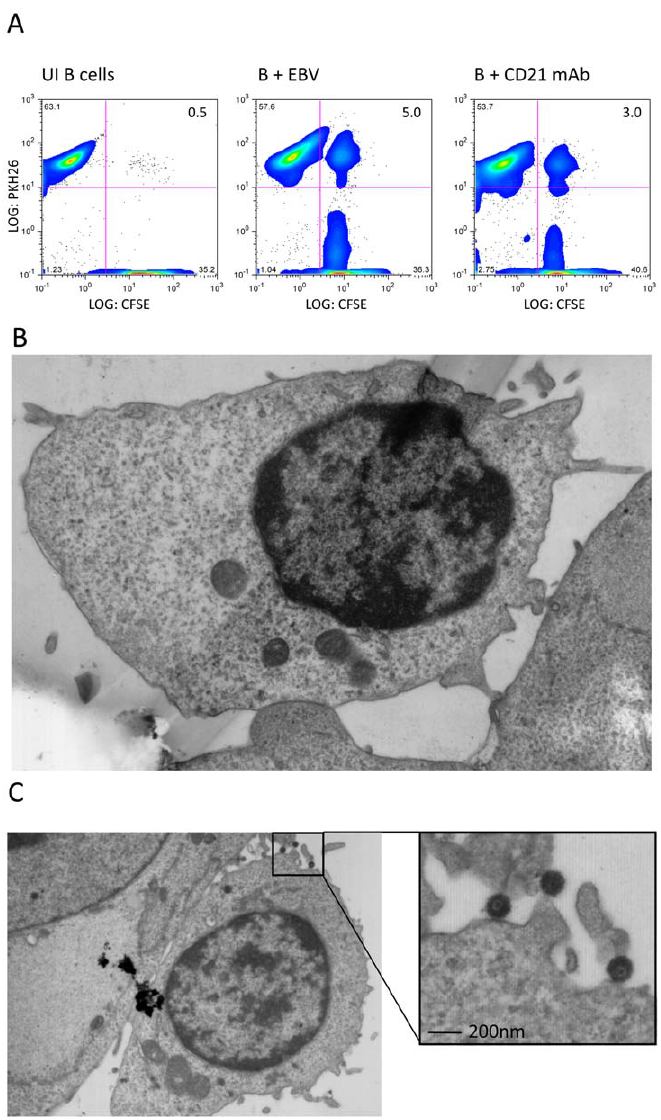
Figure 1. EBV induces firm adhesion between B cells and epithelial cells. (A) FACS profiles of conjugate formation between CFSE-labelled primary tonsillar epithelial cells (x-axis) and PKH26-labelled primary B cells (y-axis). The B cells were uninfected, EBV-infected (MOI 100, 24 h p.i.) or incubated with agonist mAb to CD21 (BL13). Conjugates appear in the upper right quadrant and the percentages of cells are shown. (B-C) Electron micrographs of B cell-epithelial cell conjugates. EBV-infected B cells (24 h p.i.) were co-cultured with primary tonsillar epithelial cells for 1 hour and immediately fixed, embedded in Epon 812, stained with uranyl acetate and ultra-thin sectioned. (B) The sites of interaction between the cell types show firm interaction. (C) A second conjugate revealing a firm interaction between the B- and epithelial cell and the fine ultrastructure of the virus particles.